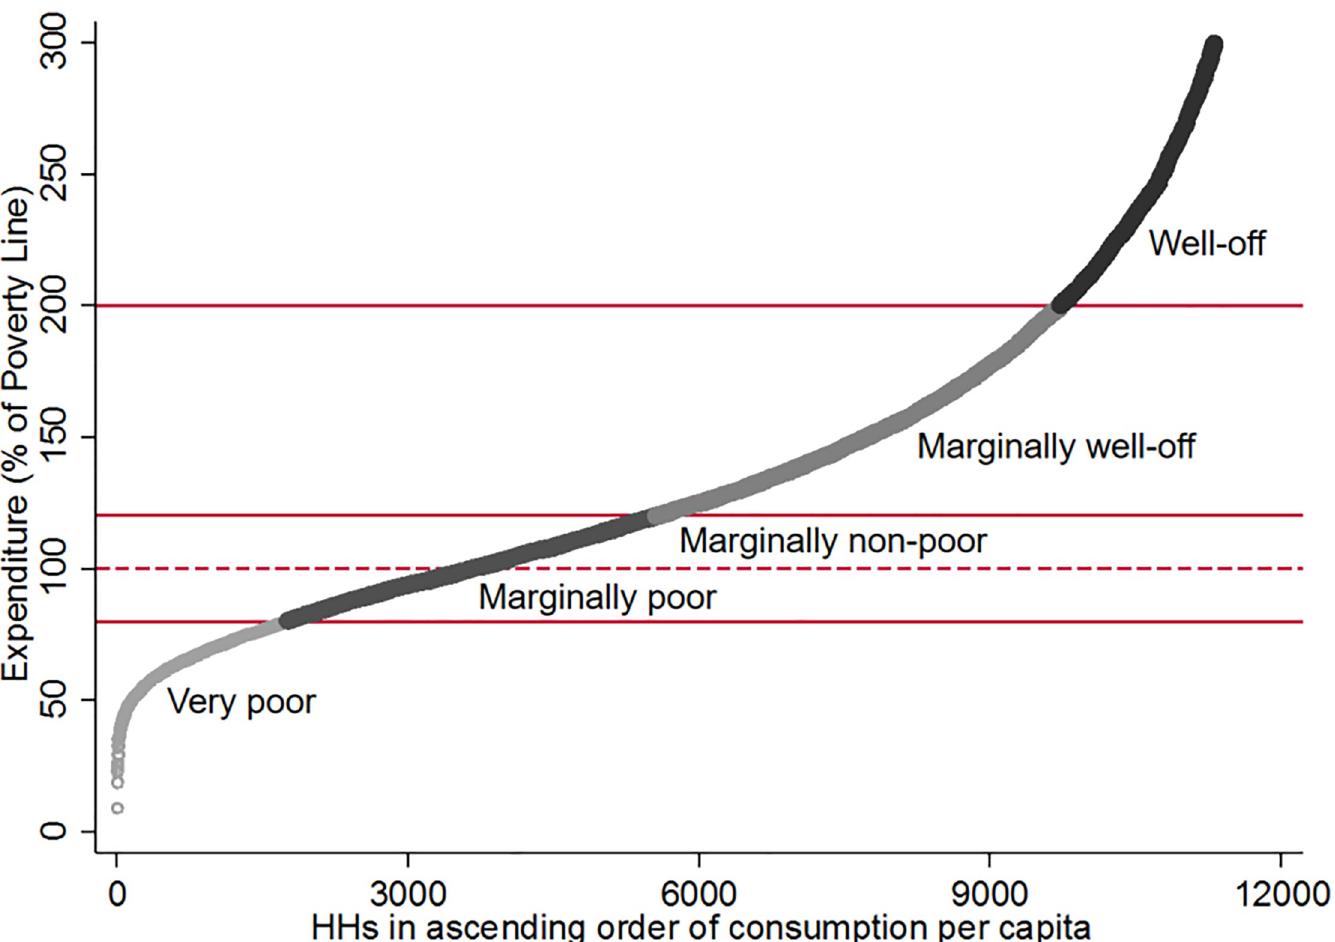
Fig 1. Classification of household categories. Notes: Households below poverty line but above 80% of the poverty line are considered marginally poor, and households above poverty line but below 120% of the poverty line are considered marginally non-poor. Together these two groups are categorized as marginally poor in the analysis. Poverty lines range from BDT 1,311 to BDT 2,038